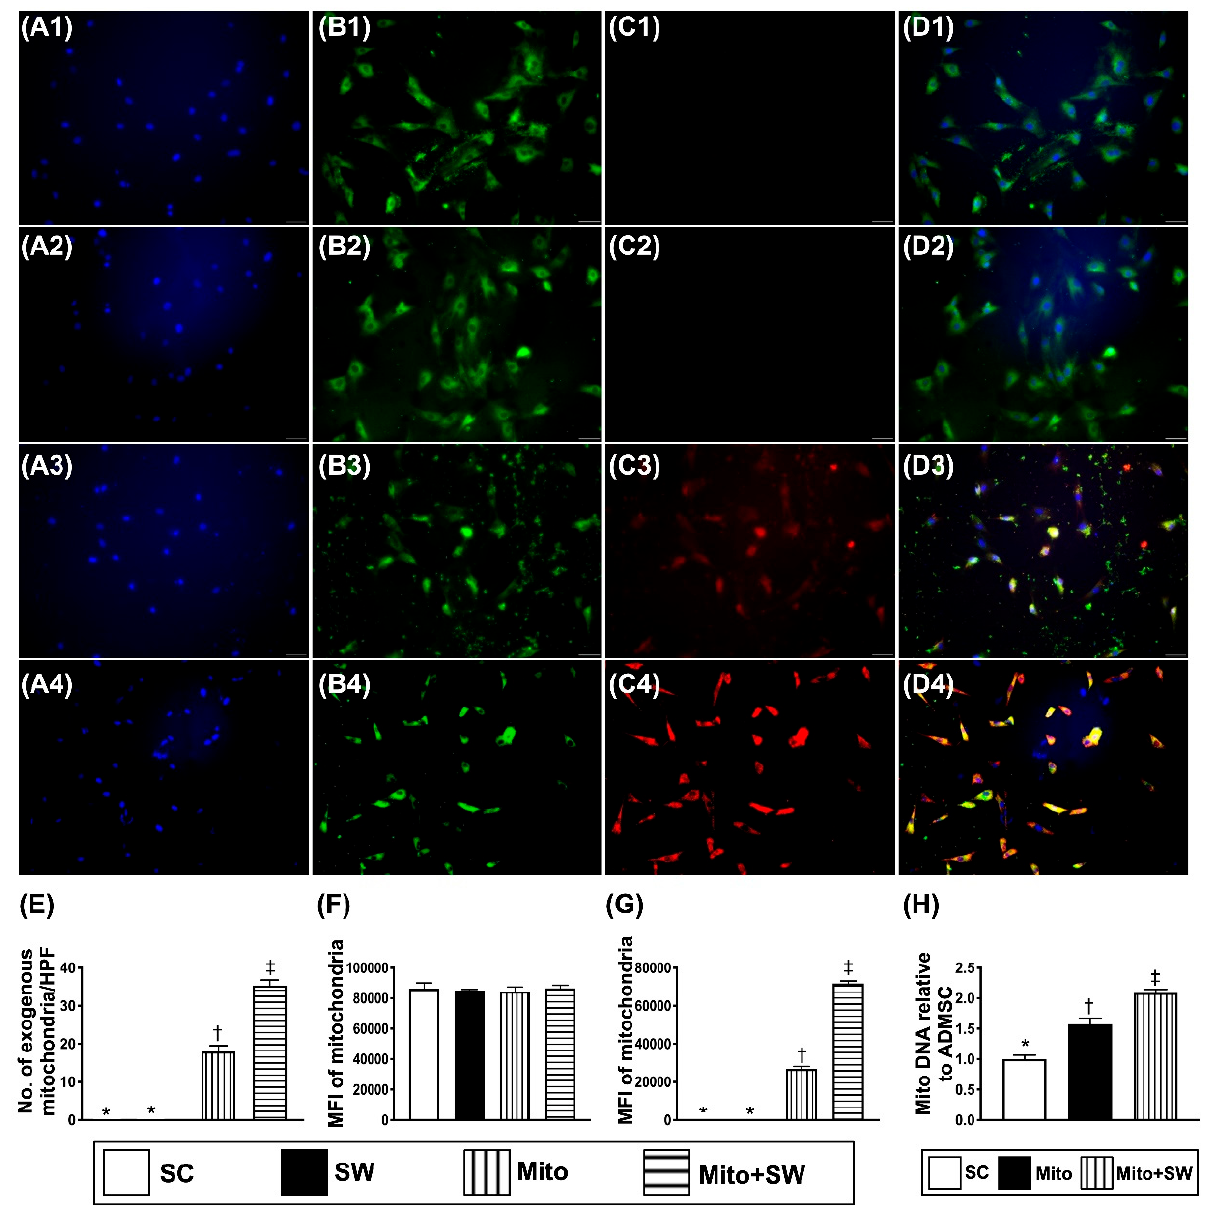
Figure 3. ECSW therapy augmented exogenous mitochondria into the rat ADMSCs. ( A1 – A4 ) Showing the DAPI stain (400 × ) for verifying ADMSCs in four groups (i.e., SC, SW, mito and mito + SW (0.2 mJ/mm 2 for 100 shots)). ( B1 – B4 ) Demonstrating MitoTracker stain (400 × ) for identifying the endogenous mitochondria (green color) among three groups. ( C1 – C4 ) Illustrating the MitoTracker stain (400 × ) for identification of exogenous mitochondria transferred into recipient ADMSCs (red color). ( D1 – D4 ) Indicating the merged picture of B and C. Pink-yellow color represented the endogenous and exogenous mitochondria colocalized together. Plentiful mitochondria were found in mito + SW group. The scale bar in right lower corner of A1–D4 represents 20 µ m. ( E ) Analytic result of number of exogenous mitochondria in the ADMSCs, * vs. other groups with different symbols (†, ‡), p < 0.001. ( F ) Analytical result of fluorescent intensity of endogenous mitochondria (indicated green fluorescent protein (GFP) of ( B1 – B4 )), p > 0.5. ( G ) Analytical result of fluorescent intensity of exogenous mitochondria (indicated green fluorescent protein (GFP) of ( C1 – C4 )), * vs. other groups with different symbols (†, ‡), p < 0.001. ( H ) Analytical result of RT-PCR of relative mitDNA, * vs. other groups with different symbols (†, ‡), p < 0.001. Scale bar in right lower corner represents 20 µ m. All statistical analyses were performed by one-way ANOVA, followed by Bonferroni multiple comparison post hoc test ( n = 6 for each group). Symbols (*, †, ‡) indicate significance (at 0.05 level). HPF = high-power field; MIF = mean fluorescent intensity; ADMSCs = adipose-derived mesenchymal stem cells; SC = sham control; mito = mitochondria; SW = shock wave.